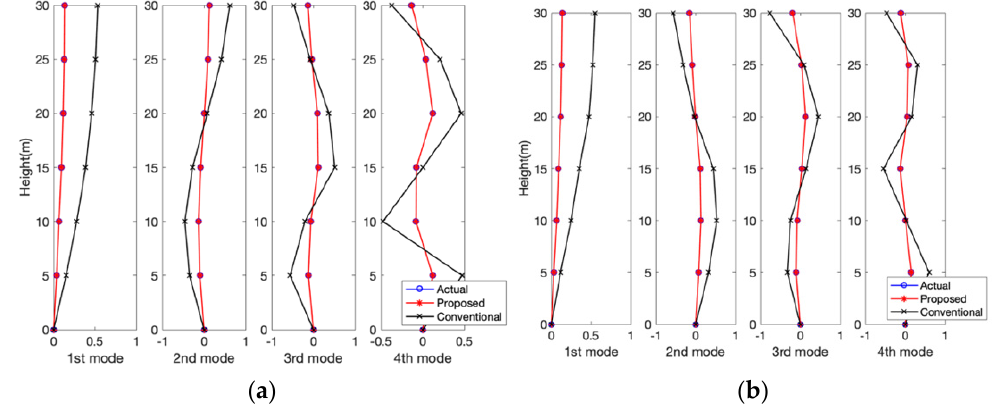
Figure 5. Updated mode shapes by two approaches: ( a ) damage case No. 1; ( b ) damage case No. 2.